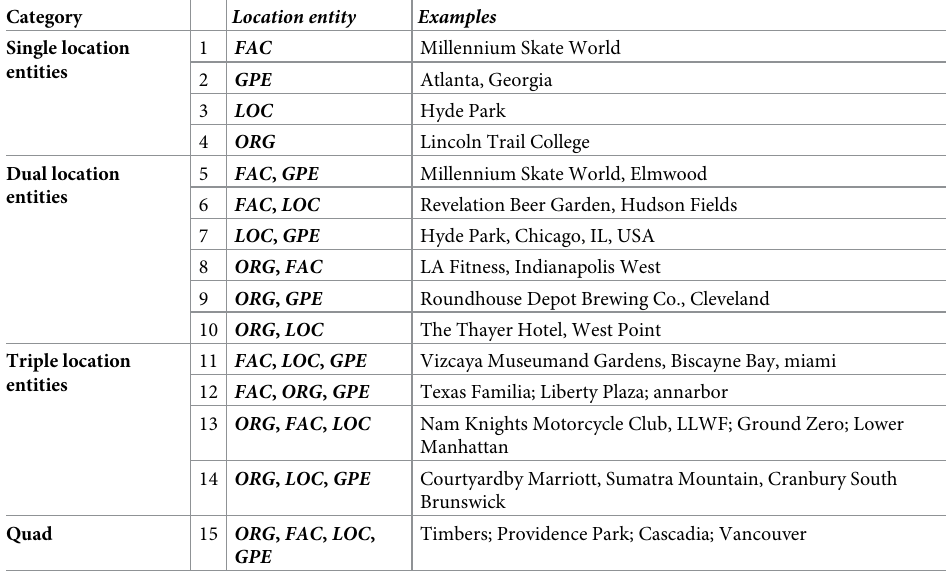
Table 2. Location entity classes with corresponding examples. The examples are given as extracted within the tweet text hence the presence of spelling errors and incorrect punctuation in some of the examples. The table is sorted by alphabetical order in each category.